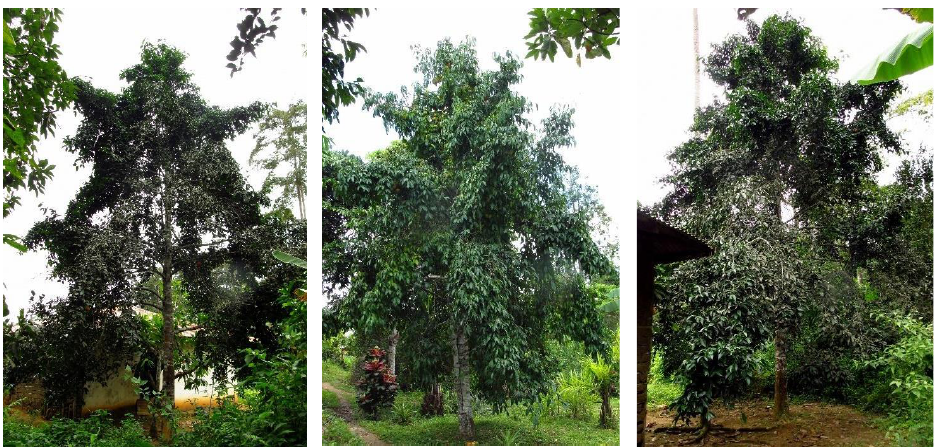
Figure 1. The most common shapes of G. kola tree canopies — pyramidal, oblong and elliptical (from left to right). Based on farmers’ estimation, trees in the Centre region were much older than the ones in the South, being on average 49 years old compared to 34 years in the South (Table 1). The biggest difference occurred between Akok (58.4 ± 20.4 years), representing the old- est trees, and Ebolowa and Kye-Ossi, representing the youngest (28.1 ± 12.9 and 24.2 ± 7.37 years, respectively). Crown diameter values did not differ significantly, whereas the var- iance in tree and trunk height was equally distributed between the two regions. On the contrary, major differences were found for DBH. Trees from the South region scored much higher values of about 85 cm on average, while the mean diameter of trees from the Cen- tral part was about 41 cm. The main difference was seen between Zoételé and the rest of the Centre study sites. Table 1. Differences in tree characteristics over geographic populations. Mean values and standard deviation (SD) supplemented with ANOVA (Tukey post hoc test) and t-test of statistical significance.